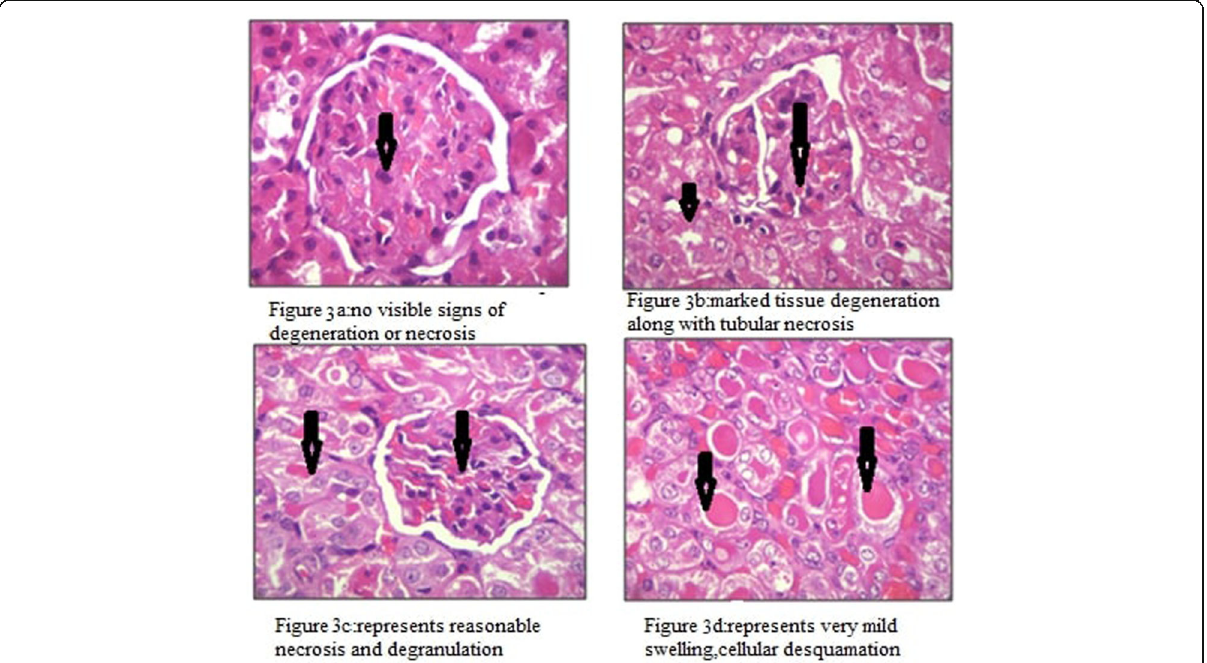
Fig. 3 Histopathological observations of the nephroprotective effect of EEAS against PCM-induced nephrotoxicity in rats where a control, b PCM alone, c PCM + EEAS 200 mg/kg, and d PCM + EEAS 400